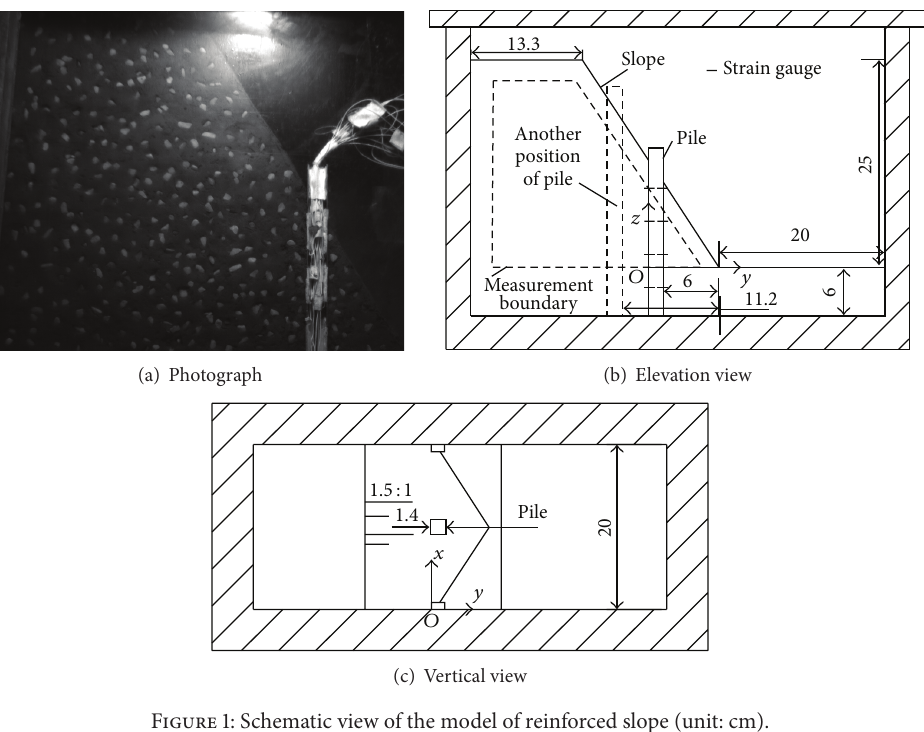
Figure 1: Schematic view of the model of reinforced slope (unit: cm).